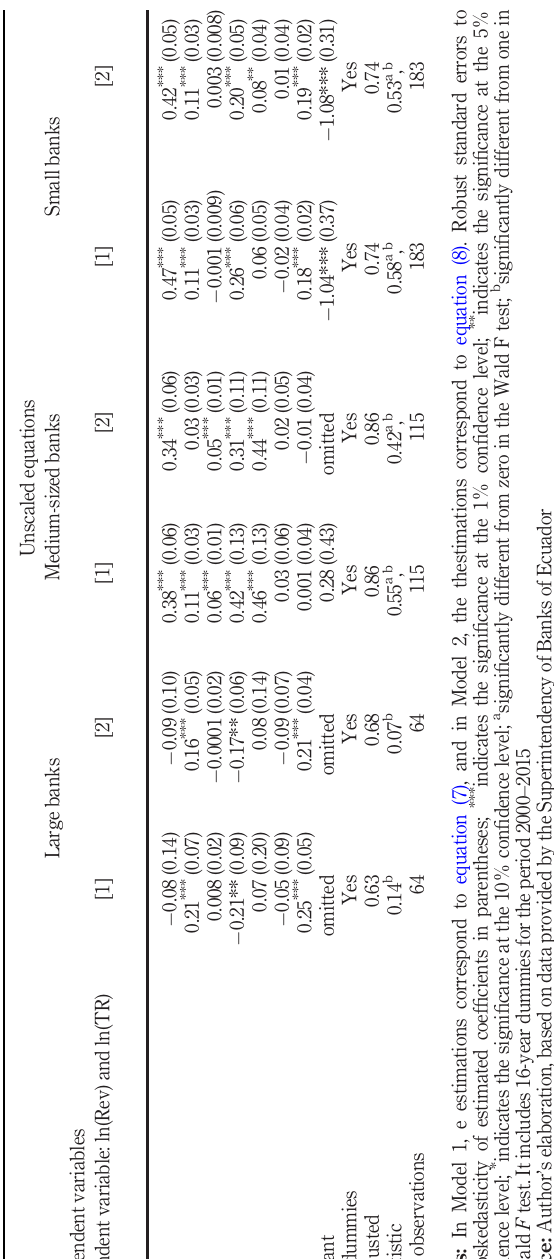
Table 9. P – R Model: